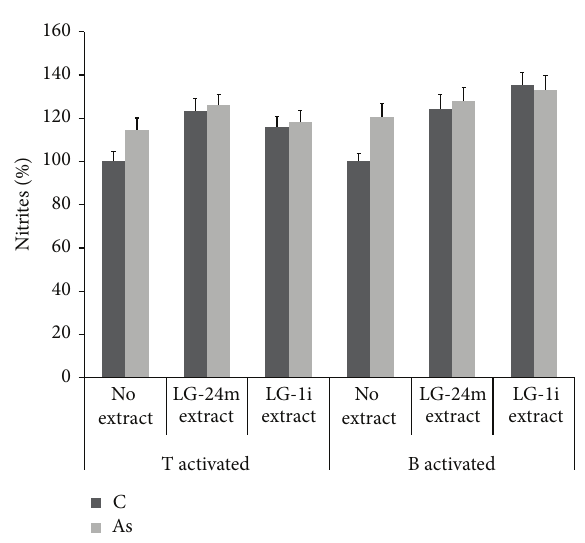
Figure 2: Nitrite % in T- and B-activated cultures from control (C) and arsenic-exposed rats (As), treated for 72 h with 100 𝜇 g/mL of aqueous L. grisebachii extracts (LG-24m: cold 24 h maceration versus LG-1i: hot 1h infusion) or without them. Results were averaged from three separate experiments ( ∗ 𝑃 < 0.01 ).